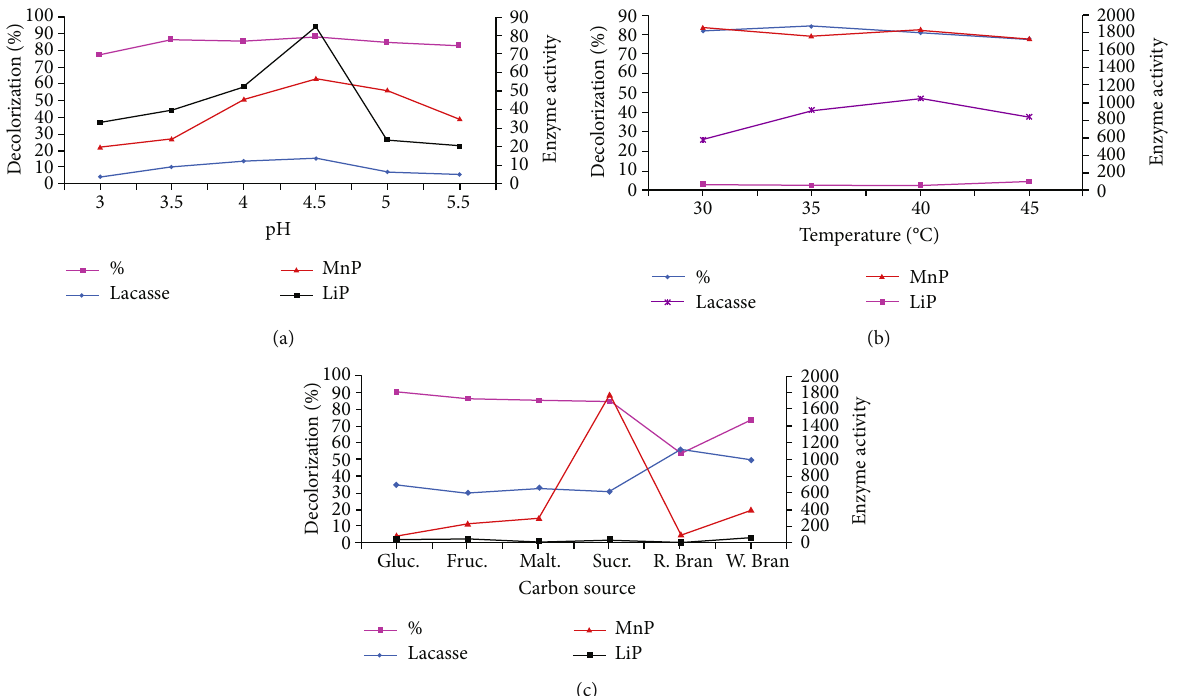
Figure 2: Removal of Drimaren Turquoise CL-B and enzyme activity of Schizophyllum commune at di ff erent (a) pH, (b) temperature, and (c) carbon source. Table 4: Enzyme assay for di ff erent nitrogen sources, inoculum size, and mediator. Laccase MnP LiP Enzyme Abs